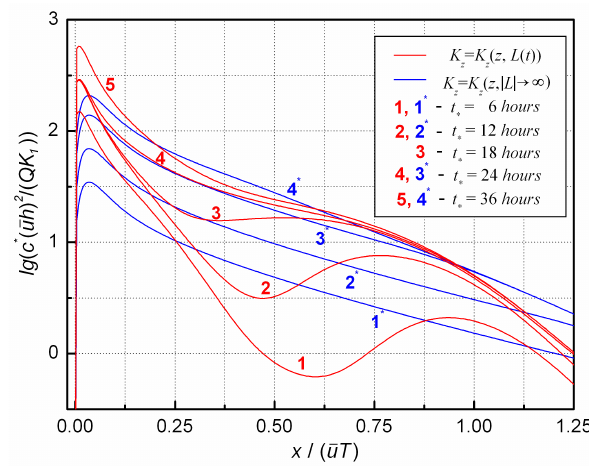
Figure 2. Horizontal profiles (at y = 0) of the normalized total de-